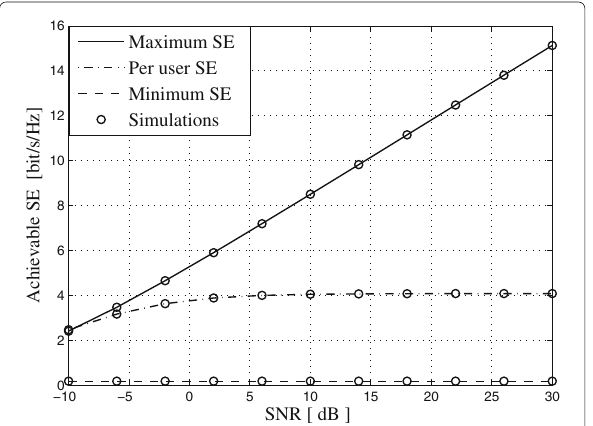
Fig. 6 The total achievable ergodic SE versus SNR. Results are shown for the maximum and minimum rate and the achievable rate of U